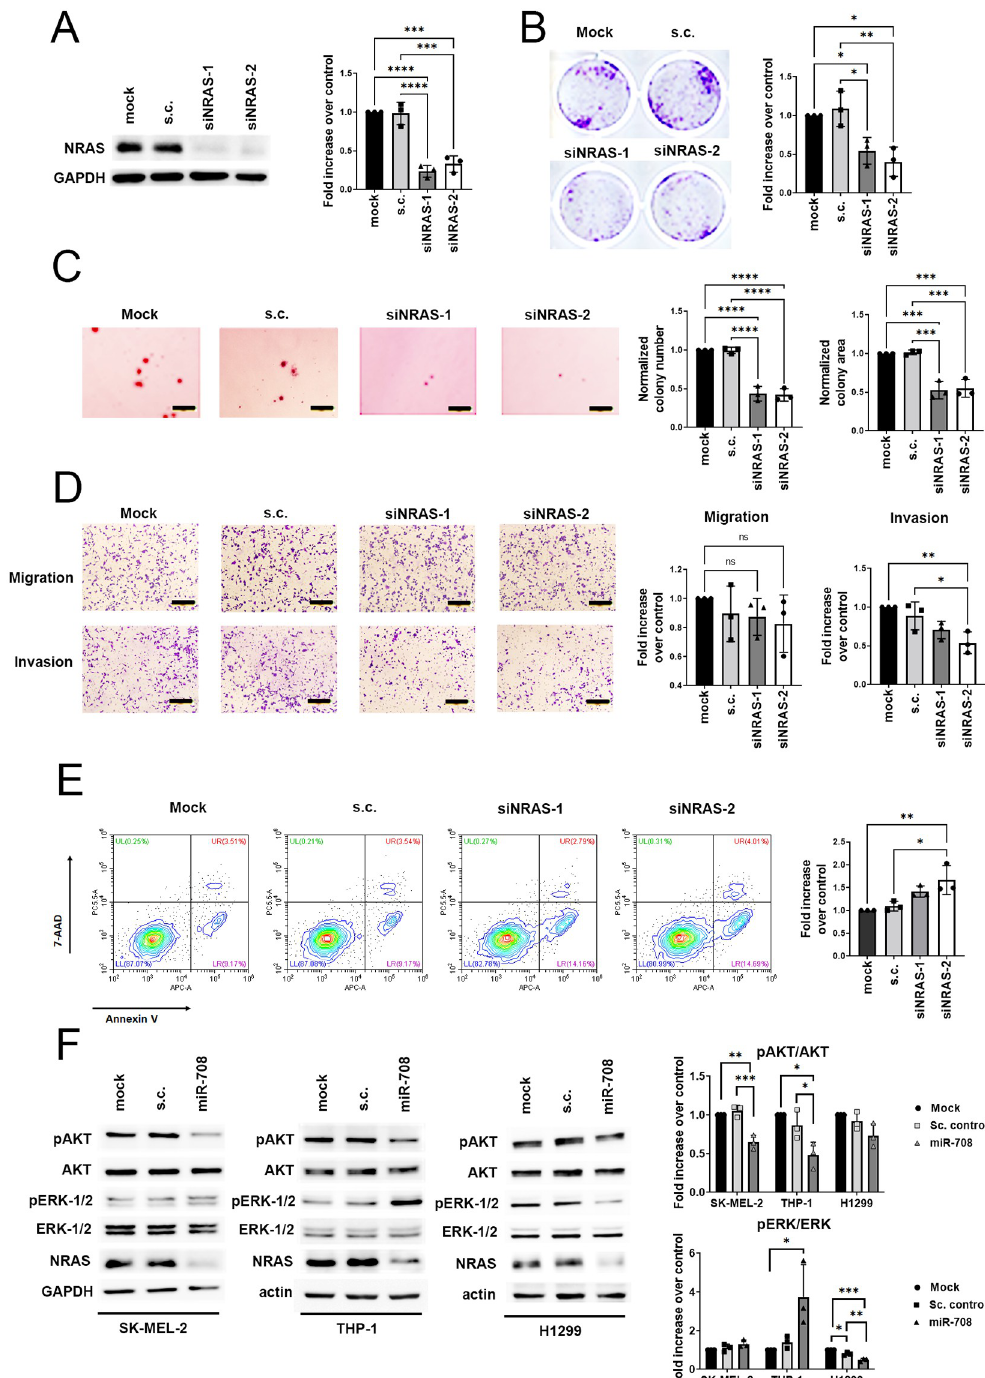
Fig 3. MicroRNA-708 impairs cell proliferation through NRAS-mediated pathway. (A) Left: Western blot analysis of SK-MEL-2 cells transfected with mock, s.c., siNRAS-1, and siNRAS-2. Right: quantitative analysis of NRAS protein levels, normalized with GAPDH level. Histogram show normalized mean ± SEM (n = 3 biological replicates) (B) Clonogenic assay of SK-MEL-2 cells transfected with mock, s.c., siNRAS-1, and siNRAS-2. Left: representative images of SK-MEL-2 cells are shown. Right: histogram represents the fold change of mean ± SD (n = 3 biological replicates) relative to mock. (C) Soft agar colony formation assay was performed in SK-MEL-2 cells expressing mock, s.c., siNRAS-1 and siNRAS-2. Left: the representative images of SK-MEL-2 cells in soft agar colony formation assay. Scale bars: 200 μ m. Right: the number and size of colonies were quantified and expressed as averaged fold increase compared to mock ± SD (n = 3 biological replicates).